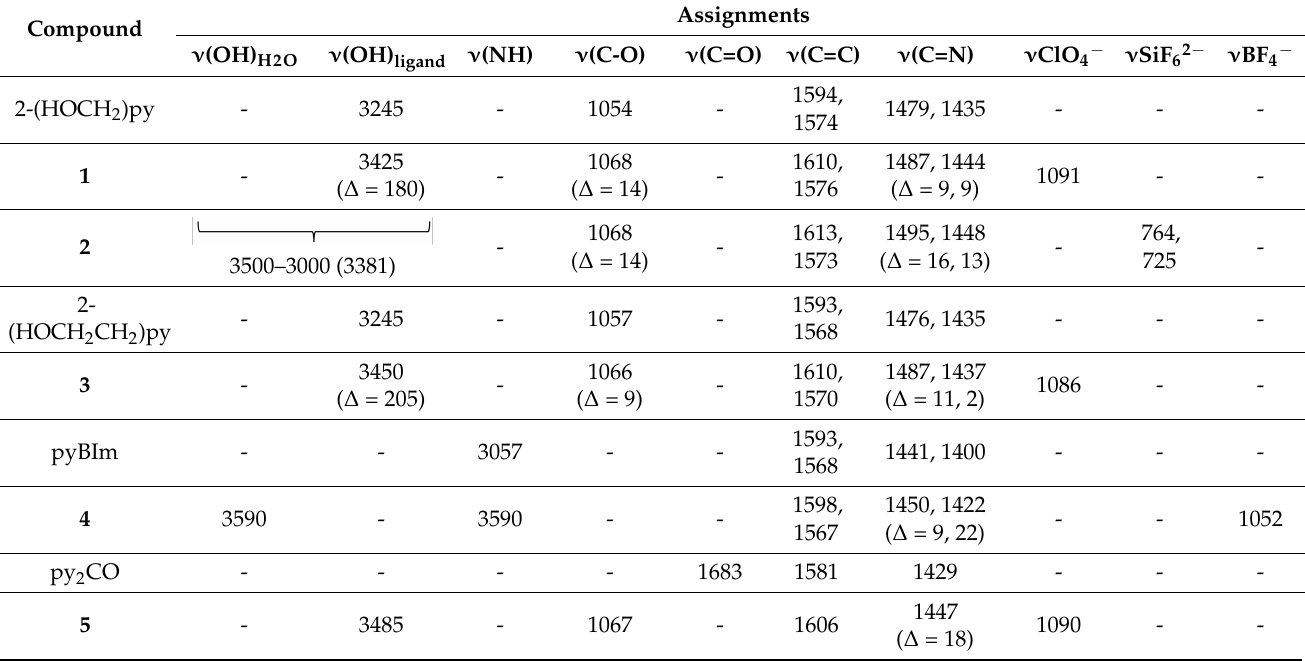
Table 3. The comparison of FTIR bands for free ligands and their copper(II)